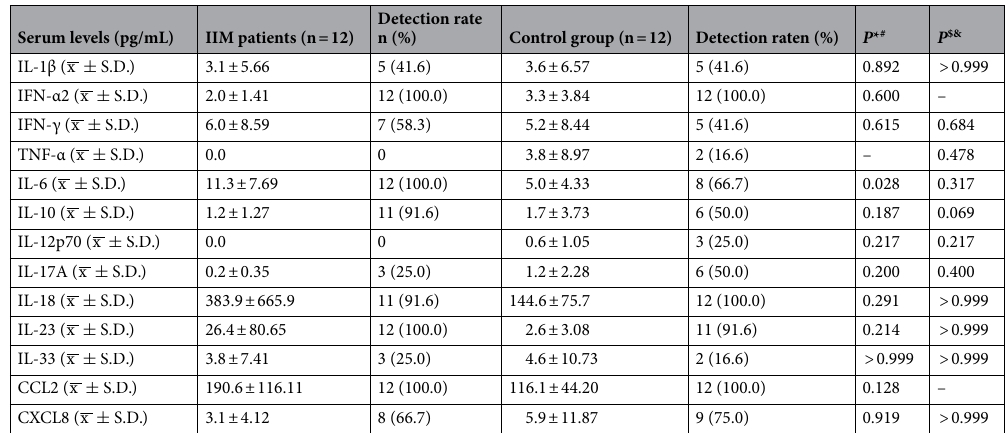
Table 3. Cytokine and chemokine serum levels in IIM patients and control group. MSA Myositis Specific Autoantibodies; MAA Myositis Associated Autoantibodies; IIM Idiopathic Inflammatory Myopathies; x mean; S.D. standard deviation; pg picogram; mL milliliter; IL interleukin; IFN interferon; TNF Necrosis Tumor Factor; CCL2 chemokine (C–C motif) ligand 2; CXCL8 chemokine (C-X-C motif) ligand 8. *We compared cytokine and chemokine serum levels between IIM patients and control group. # Mann–Whitney U test with Fisher’s exact test. $ We compared the detection rate of cytokines and chemokines between IIM patients and control group. & Fisher’s exact test.